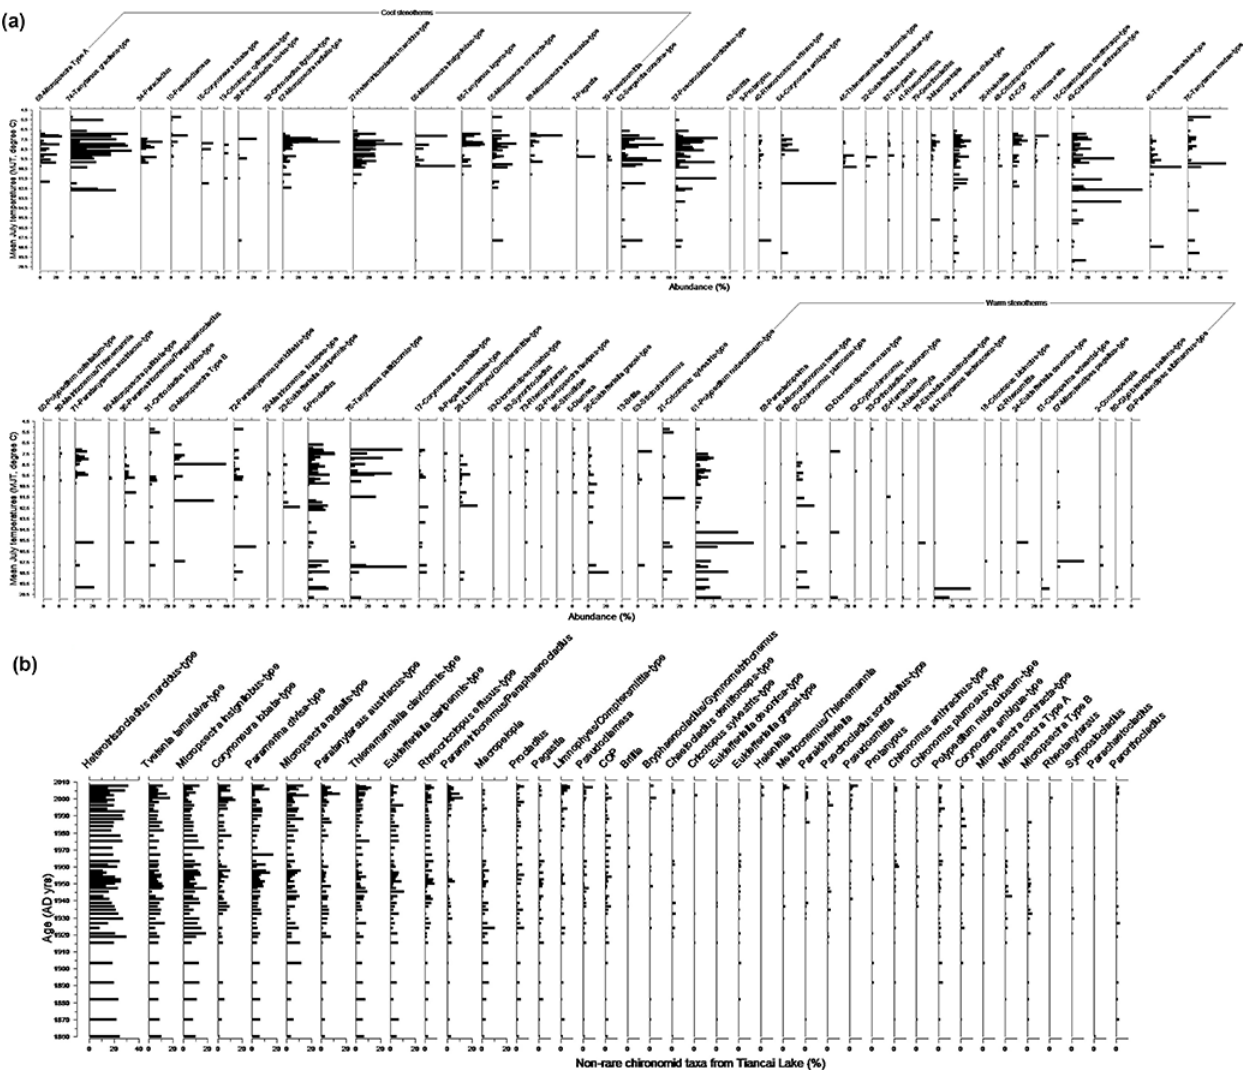
Figure 2. (a) Chironomid species stratigraphy diagram of the 85 non-rare taxa with N 2 >2. Mean July temperature is on the y axis and taxon abundance is in percentage. The taxon code is correspondent to the code used in Fig. 3a. Warm and cold stenotherms were identified and grouped based on optical observation and the beta coefficient (from low to high) calculated based on the bootstrap weighted-average partial least squares (WA-PLS) model for each species in C2 software (Juggins, 2005). (b) Forty-one (41) non-rare chironomid species present in the short core (28cm) from Tiancai Lake where the calibrated 210 Pb-based age is on the y axis and taxon abundance is in